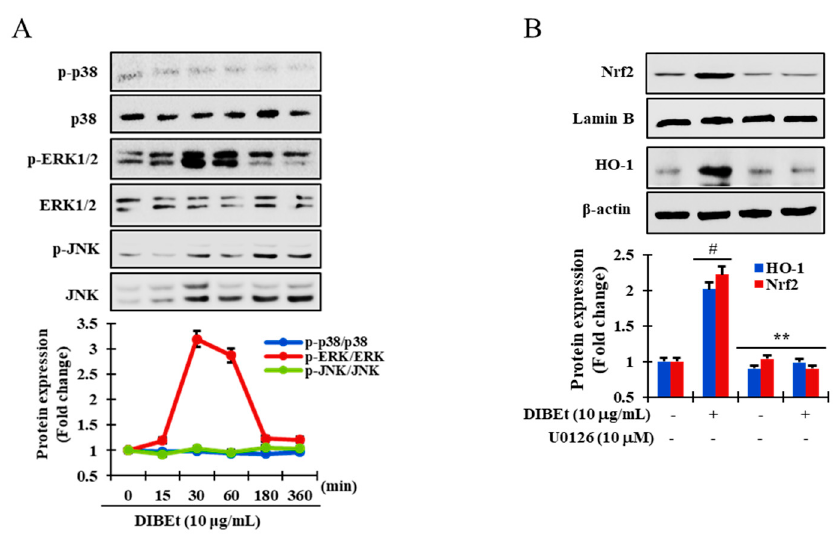
Figure 5. DIBEt facilitates Nrf2 translocation by activating ERK1 / 2. RAW 264.7 cells were pretreated with DIBEt (10 µ g / mL) at the indicated times. Immunoblotting was performed to evaluate kinase activity ( A ). Cells were treated with DIBEt in the presence and absence of the specific inhibitor U0126. The protein levels of Nrf2 and HO-1 were analyzed by Western blot ( B ). Mean ± SD ( n = 3). # p < 0.001; ** p < 0.05, compared to no treatment. Statistical analysis was performed using one-way ANOVA.